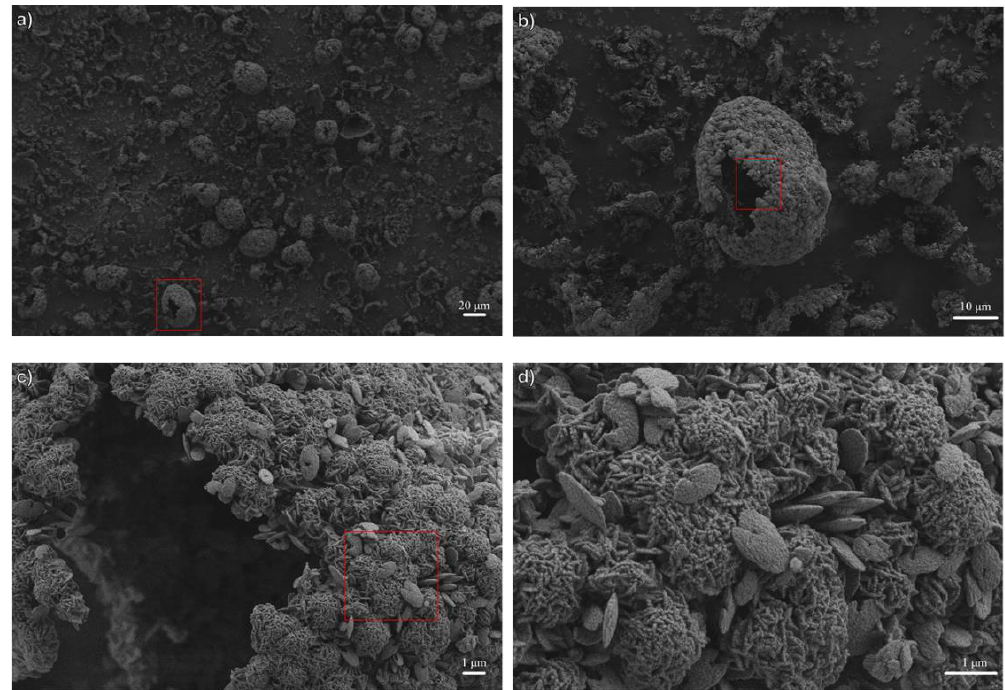
Figure A2. ( a – d ) SEM images showing the clusters of the sample obtained at 150 °C and 24 h at different magnifications. Red squares stand for the higher magnification of the following image.